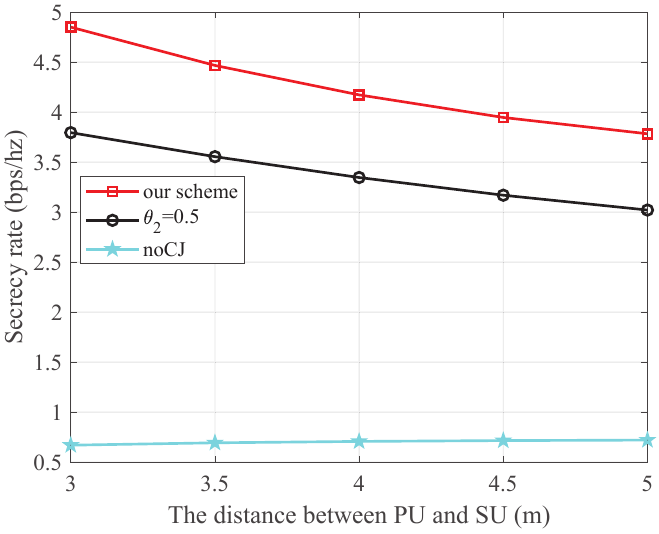
Figure 4. The secrecy rate versus the distance between PU and